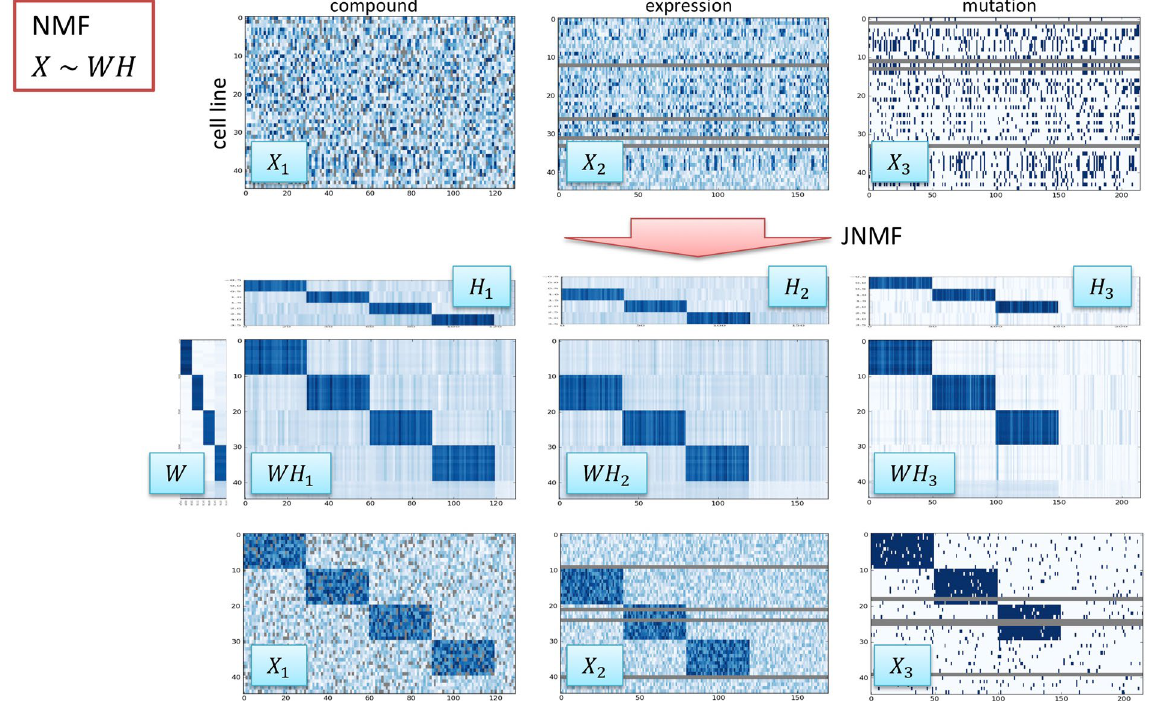
Figure 2. JNMF multi-dimensional clustering with simulated data. Simulated compound, expression, and mutation data are clustered using JNMF to detect co-modules. The simulated compound dataset in continuous format X 1 contains four modules as well as missing components. The simulated expression dataset in continuous format X 2 contains three modules as well as missing profiles in rows. The simulated mutation dataset in binary format X 3 contains three modules as well as missing profiles in rows. Continuous X 1 and X 2 have Gaussian noise, and binary X 3 is partially flip-flopped as noise. JNMF generates meta-profiles H 1 , H 1 , H 3 , and W